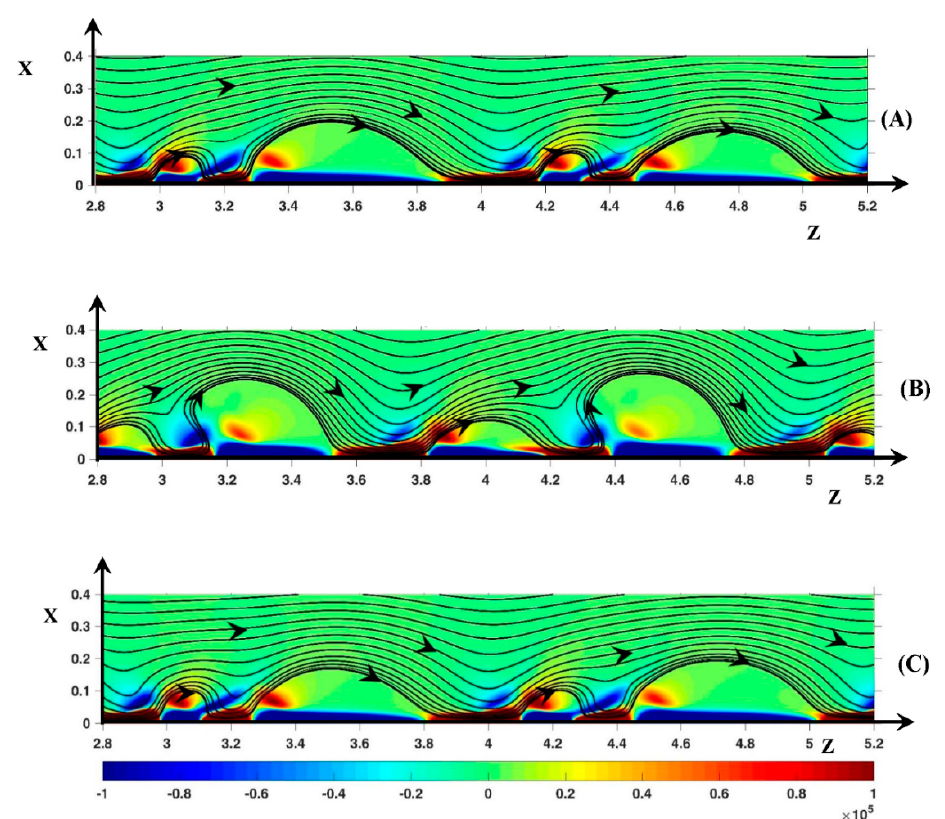
→  ( ) F Tot ) Tot z . F Black z − = ± = , 1 D .